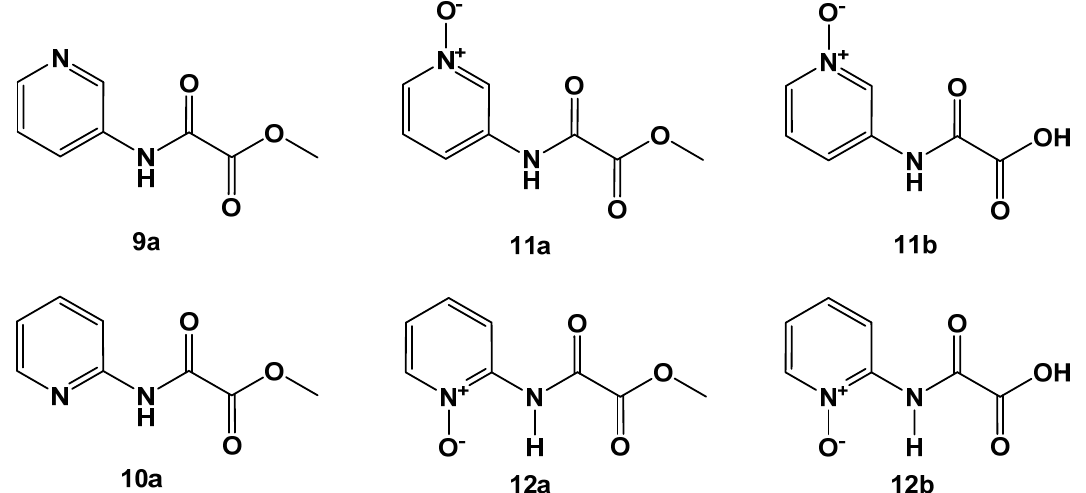
Figure 6. Oxalamic acid derived from 3-aminopyridine ( upper lane ) and 2-aminopyridine building blocks ( lower lane ). Table 3. N -(pyridine-3-yl)oxalamic acid derivatives 9a – 11b . N -(pyridine-2-yl) oxalamic acid deriv-